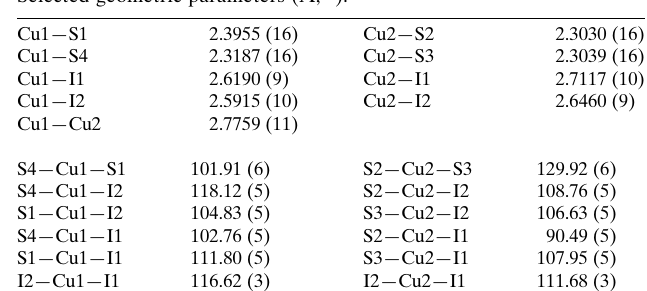
Table 2 Selected geometric parameters (A˚ , (cid:5) ).